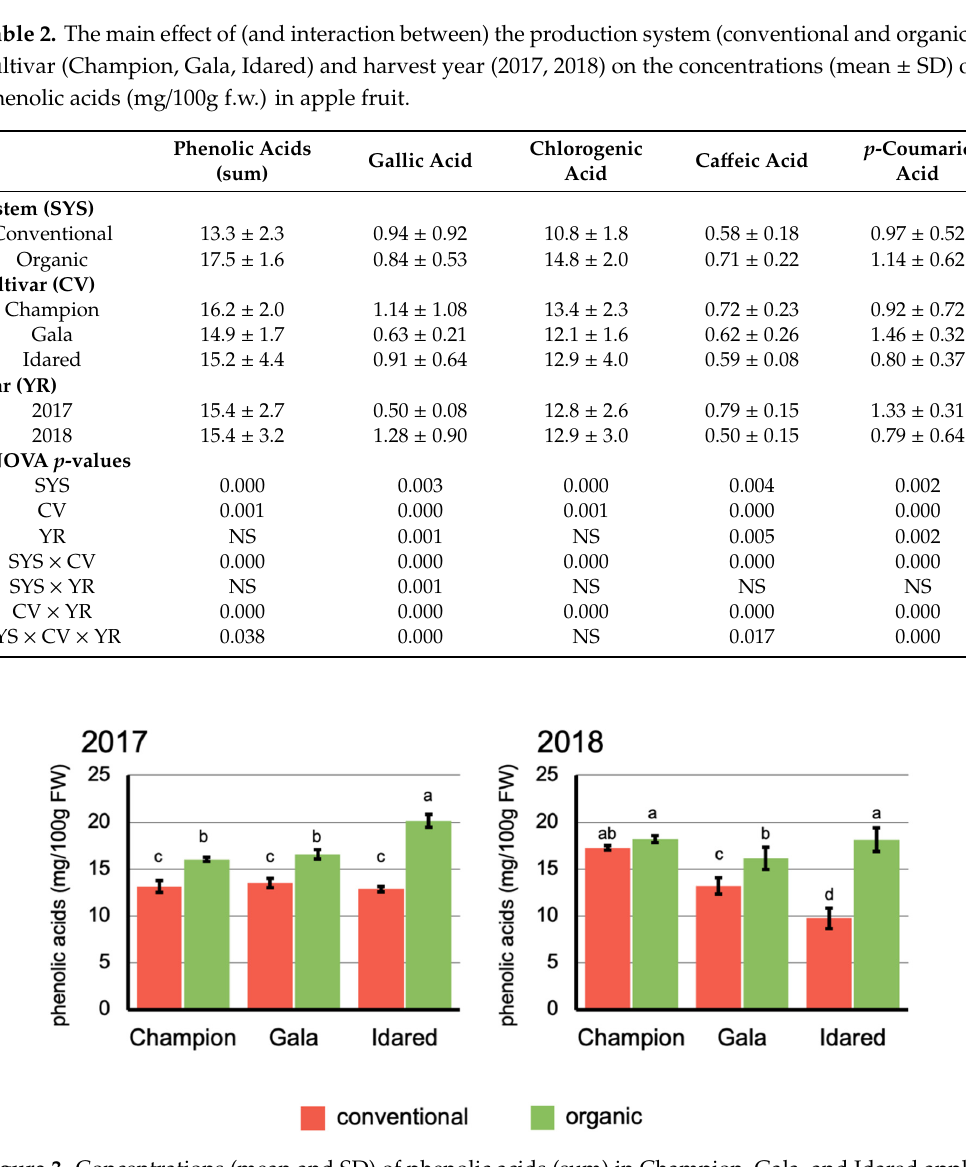
Figure 3. Concentrations (mean and SD) of phenolic acids (sum) in Champion, Gala, and Idared apple fruits collected from organic and conventional orchards in 2017 and 2018 growing seasons. Within each season and group of compounds, bars marked with the same letters are not significantly different at p < 0.05.